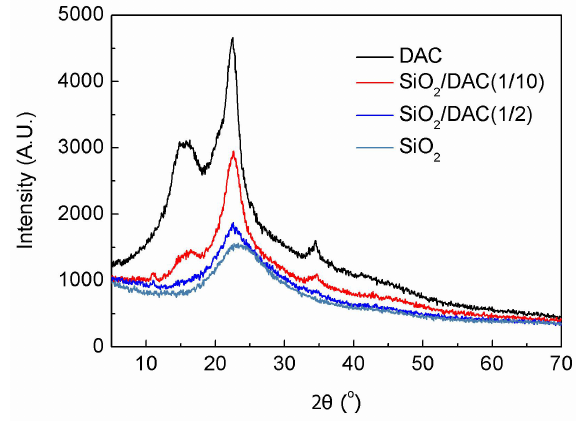
Figure 3. XRD patterns of the SiO 2 /DAC hybrid materials.